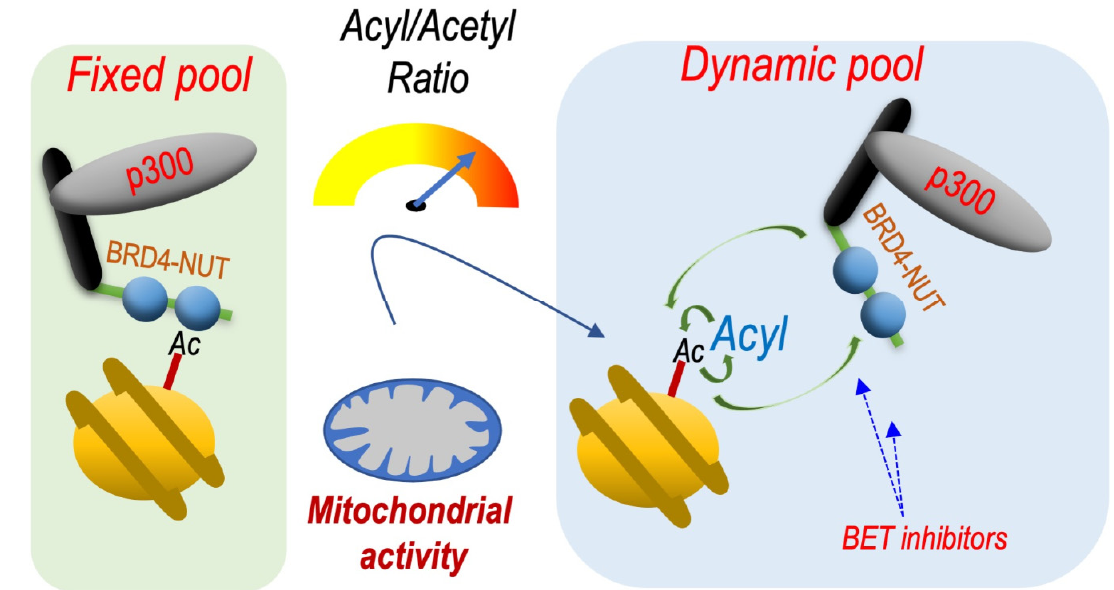
Figure 3. Metabolically controlled variations of the H4K5 acylation/acetylation ratio regulate the dynamics of BRD4-NUT chromatin binding. The mechanism schematized is based on data published by Gao and colleagues [26]. The activation of mitochondrial activity, especially an enhanced fatty acids beta-oxidation, leads to increased levels of butyrylation and crotonylation of H4 lysine 5 compared to its acetylation. Since BRD4 bromodomains are unable to bind H4K5bu or H4K5cr, the relative increase of these two modifications loosens the interaction between BRD4 and acetylated chromatin, leading to an increased dynamics of BRD4-NUT binding in the foci. Gao and colleagues showed that, under these conditions, BRD4 becomes more sensitive to the BET bromodomain small molecule inhibitor, JQ1. Therefore, based on these data, one can speculate that enhancing different metabolic pathways favouring histone >3 carbon chain acylations, would make BRD4-NUT expressing NC tumours more sensitive to a BET inhibitor treatment.